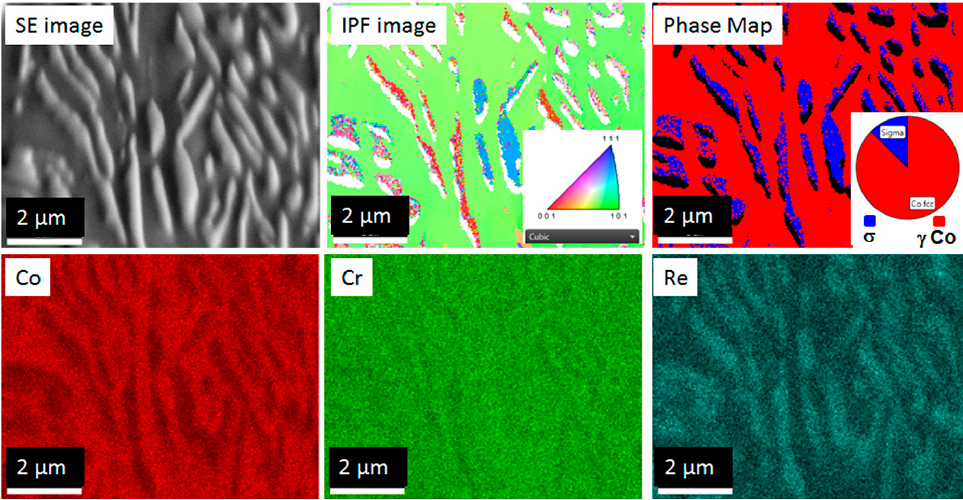
Figure 7. Combined EBSD + EDS measurement: CoRe23-25 alloy after 800 ◦ C heat treatment. Table 4. Constitution of phases in the Co matrix during and after the heat treatment: ( a ) at RT after cooling from heat treatment temperature; ( b ) at high temperature during heat treatment.